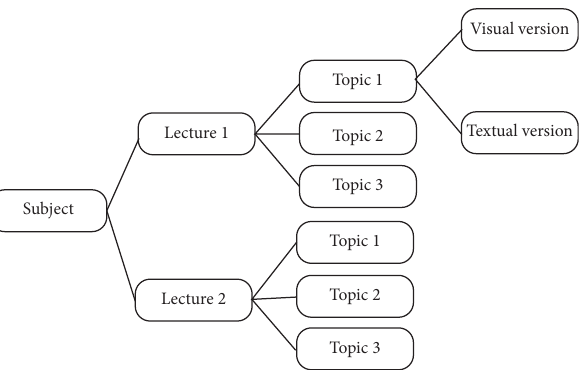
Figure 2: Hierarchical representation of course contents.